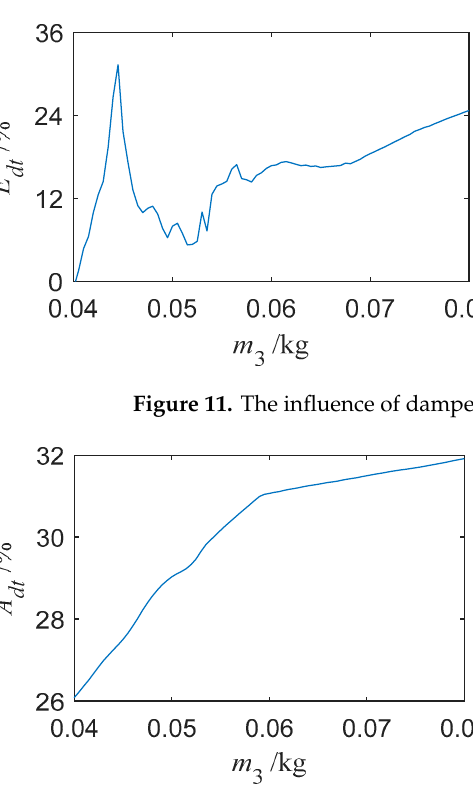
Figure 12. The influence of damper mass on the reduction of the maximum absolute value of vibrational response.